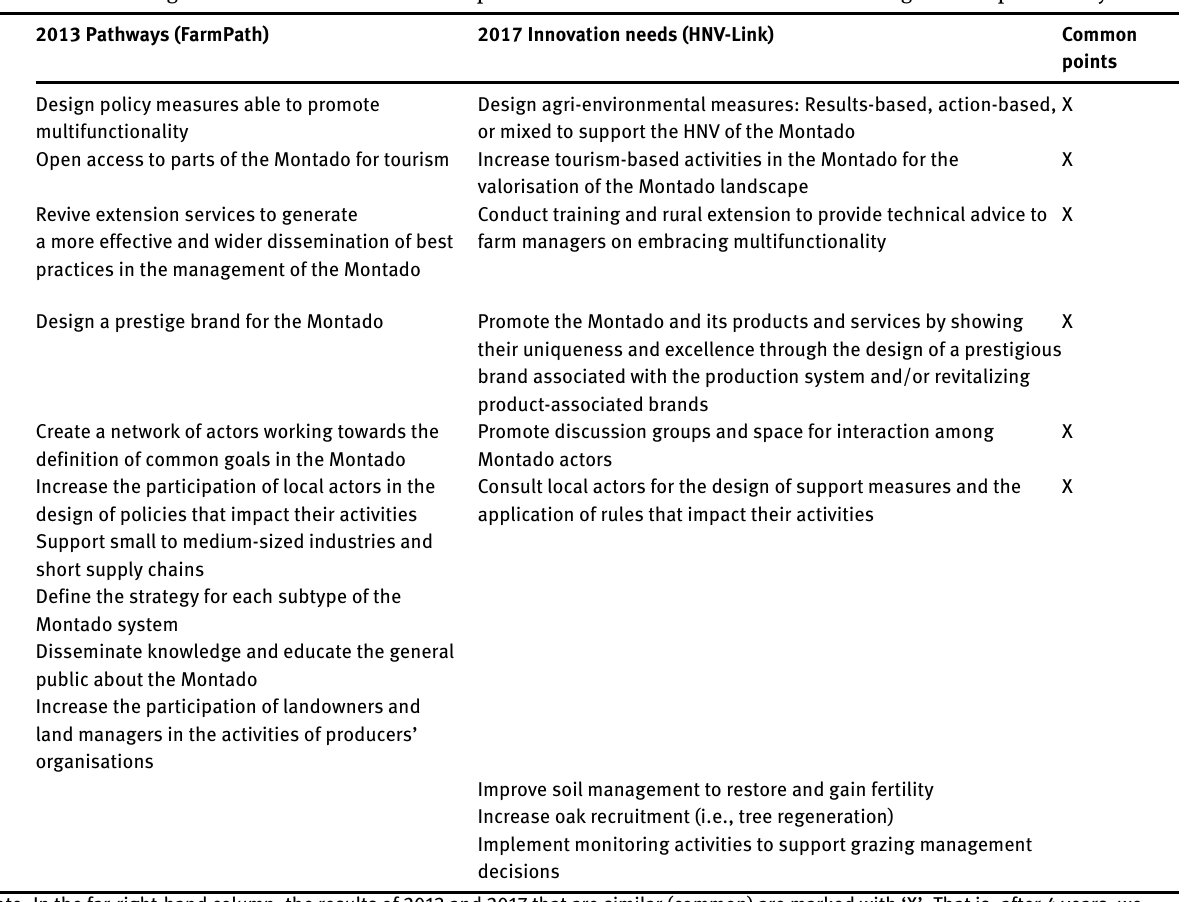
Table 1 : Changes that need to occur with respect to the maintenance of the Montado agro-silvo-pastoral system